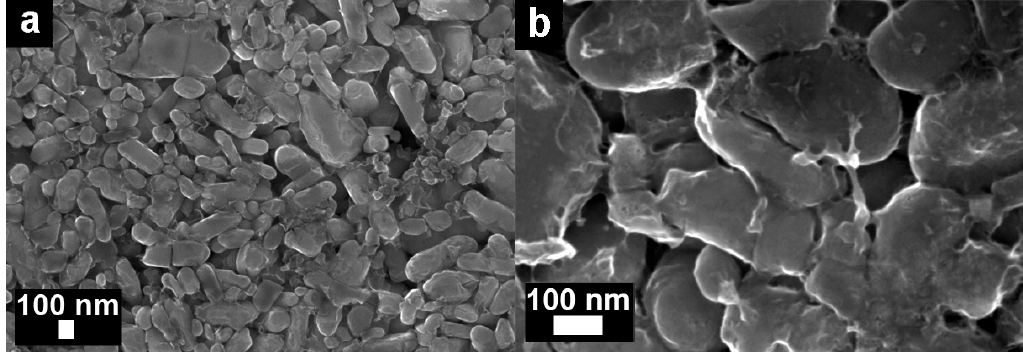
Figure 3. SEM images of LFP PEDOT:PSS / CMC electrodes: ( a ) freshly prepared; and ( b ) after long-term cycling (our data from Ref. [69]).